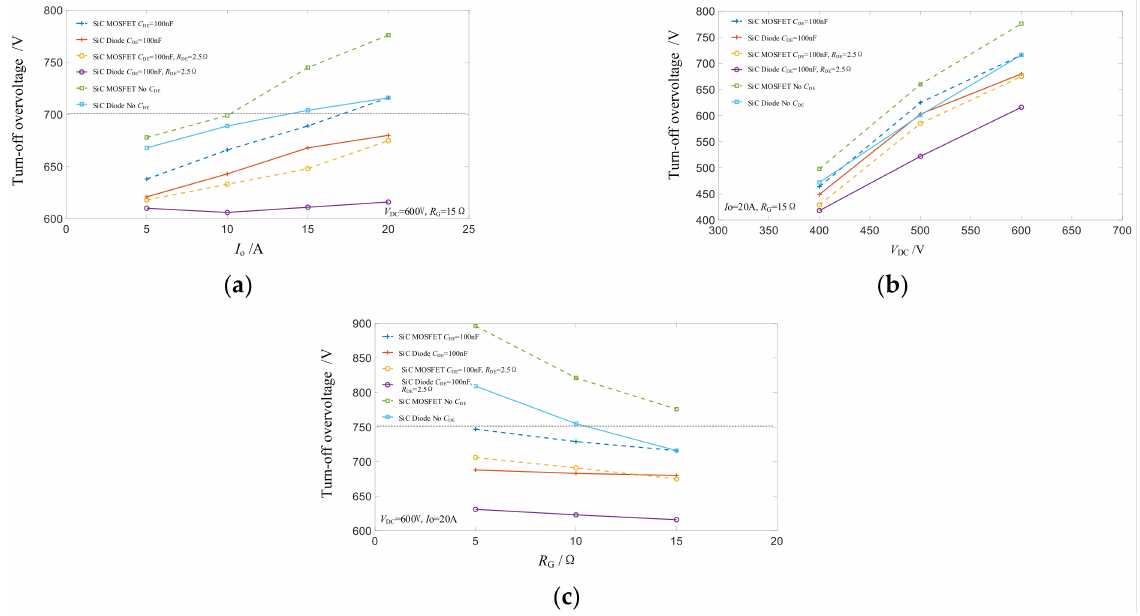
Figure 12. Turn-off overvoltage of the SiC diode and the SiC MOSFET with DC-side snubbers ( a ) at different I o , ( b ) at different V DC , and ( c ) at different R G .